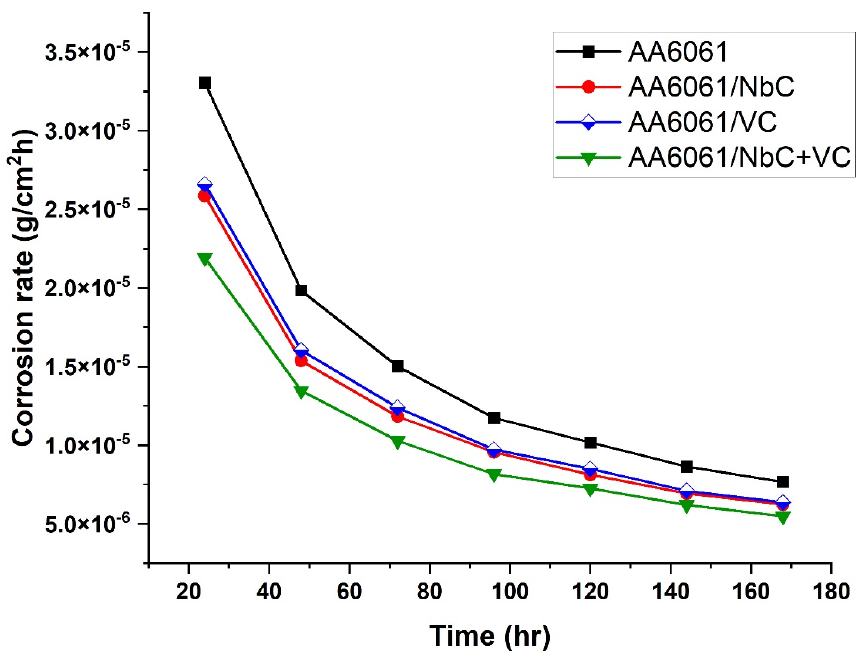
Figure 10. The corrosion rate of the investigated samples against the immersed time in hours.